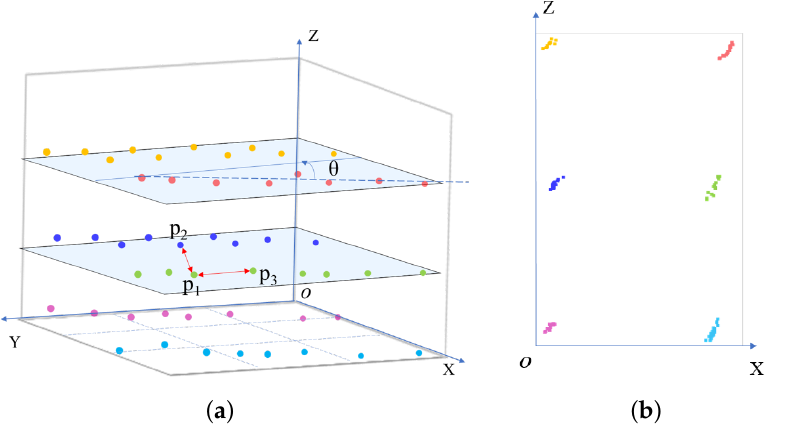
Figure 7. Spatial line clustering illustration of the power line points. ( a ) The power line points before projection. ( b ) The power line points are clustered together after